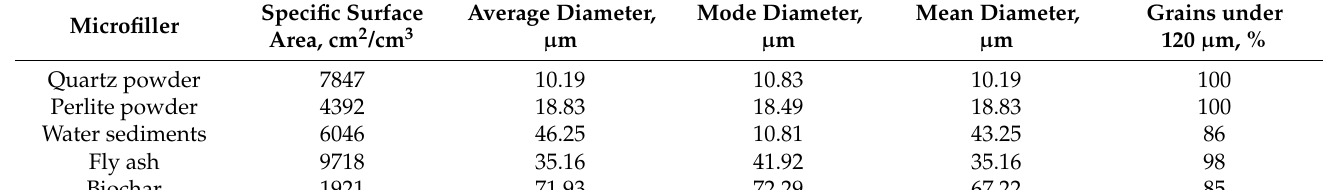
Table 1. Selected characteristics of waste and non-waste polymer composite fillers.